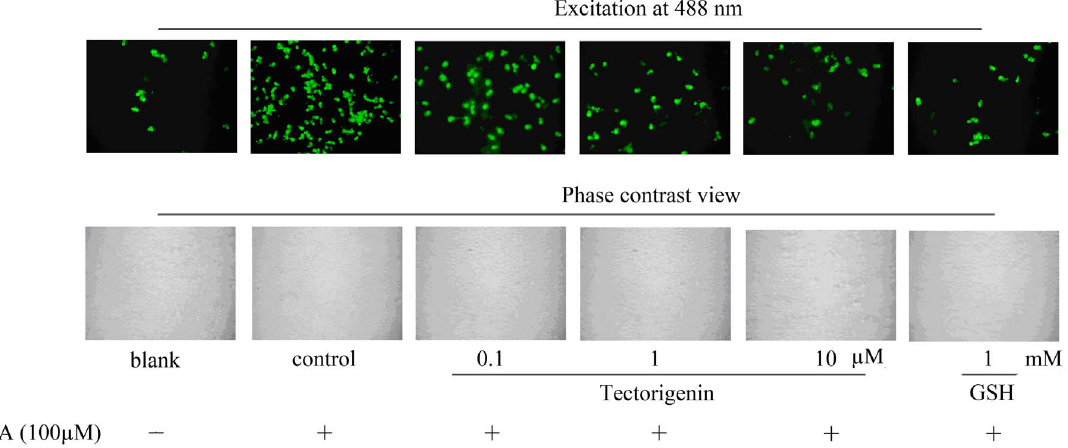
Figure 1. Tectorigenin decreased ROS production in PA-stimulated HUVECs. Cells were incubated with tectorigenin (0.1, 1, 10 m M), GSH or vehicle (medium containing 0.1%DMSO and 10% BSA) for 30 min, and then stimulated without o with PA (100 m M) for 30 min. Intracellular ROS fluorescence images were shown by using a fluorescence microscope, and the intensity of green fluorescence is used to assess ROS production. The GSH was taken as positive controls.